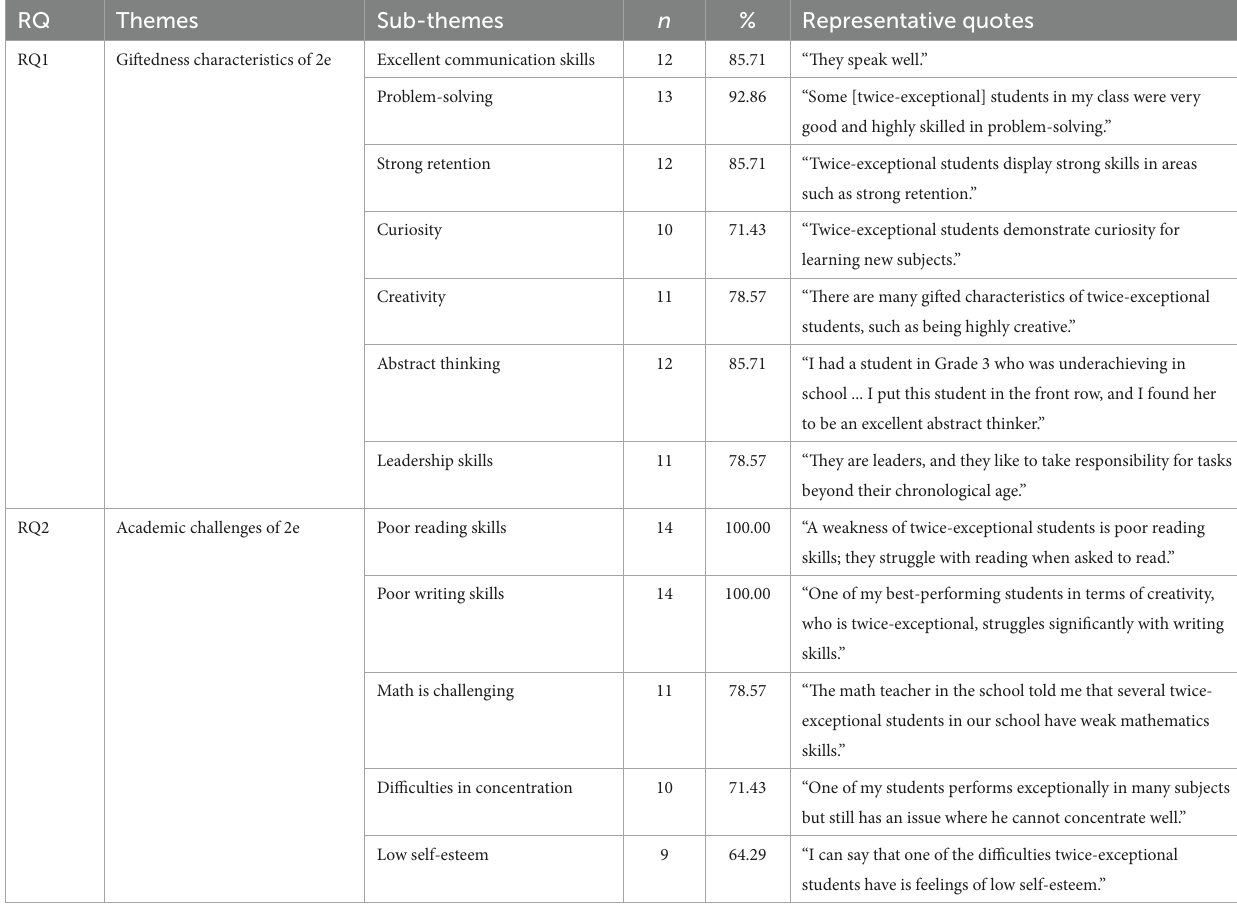
TABLE 1 Themes and subthemes for each research question regarding the twice